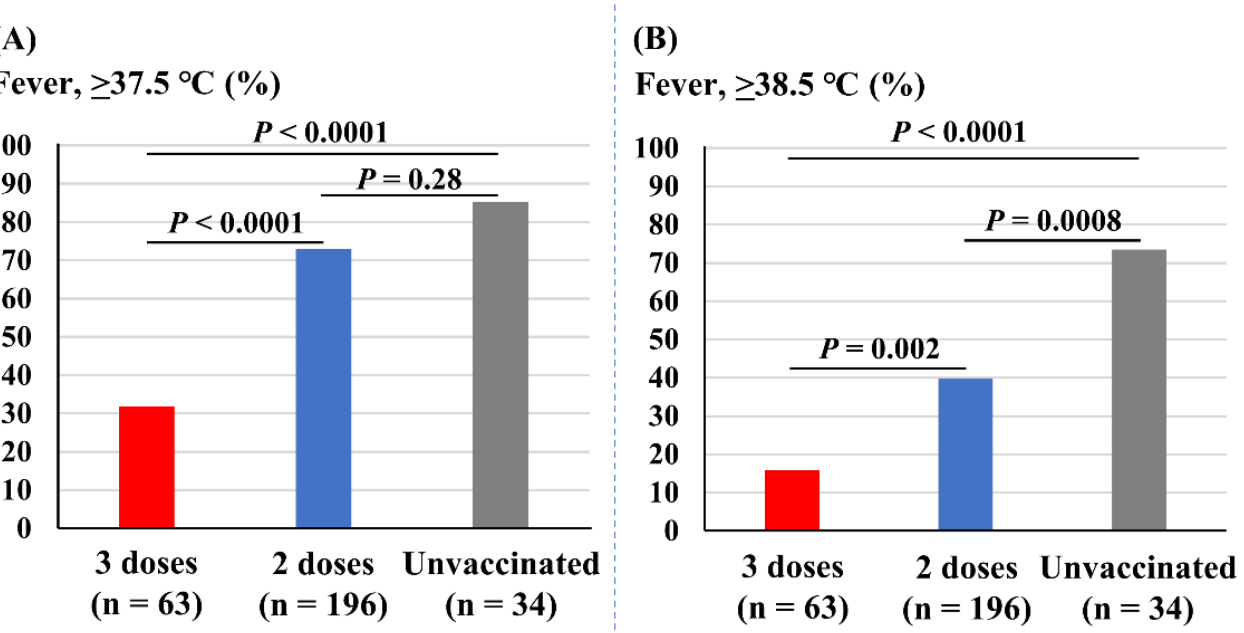
Figure 3. Associations of vaccine doses and incidences of fever. ( A ) Incidence of fever (37.5 °C or higher). ( B ) Incidence of fever of 38.5 °C or higher. Table 2. Odds ratios of f ever of ≥37.5 °C or ≥38.5 °C after three doses of vaccine compared with two doses and those who were unvaccinated.